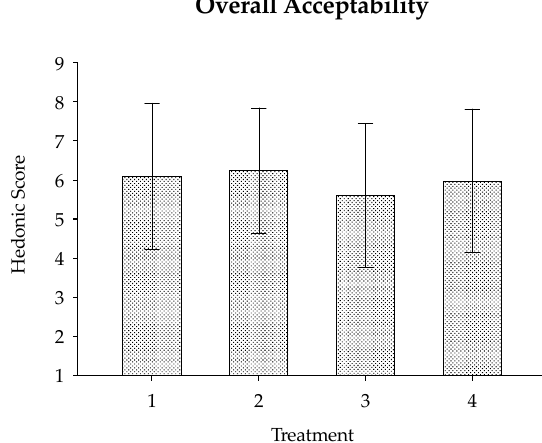
Figure 3. Panellists ( n = 111) rated the texture of four probiotic yogurt treatments using a nine-point hedonic scale ranging from 1 (dislike extremely) to 9 (like extremely). A one-way repeated-measures ANOVA and Fisher’s least significant difference test were used to analyse statistically significant differences ( p < 0.05) between mean hedonic scores. Significant differences ( p < 0.05) between treatments are denoted by different lowercase letters ( a–c ) above each bar graph. (Treatment 1 indicates 100% cow milk (control); Treatment 2, 75% cow milk + 25% soymilk; Treatment 3, 50% cow milk + 50% soymilk; Treatment 4, 25% cow milk + 75% soymilk).